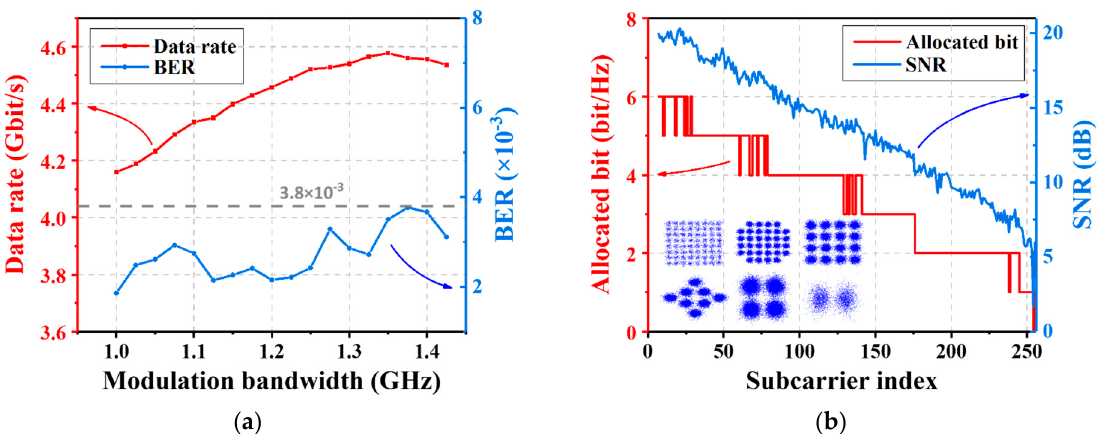
Figure 7. ( a ) Transmission data rate and BER versus modulation bandwidth; ( b ) subcarrier SNR and bit allocation. Insets: constellation diagrams of 64QAM, 32QAM, 16QAM, 8QAM, 4QAM and 2QAM (BPSK).